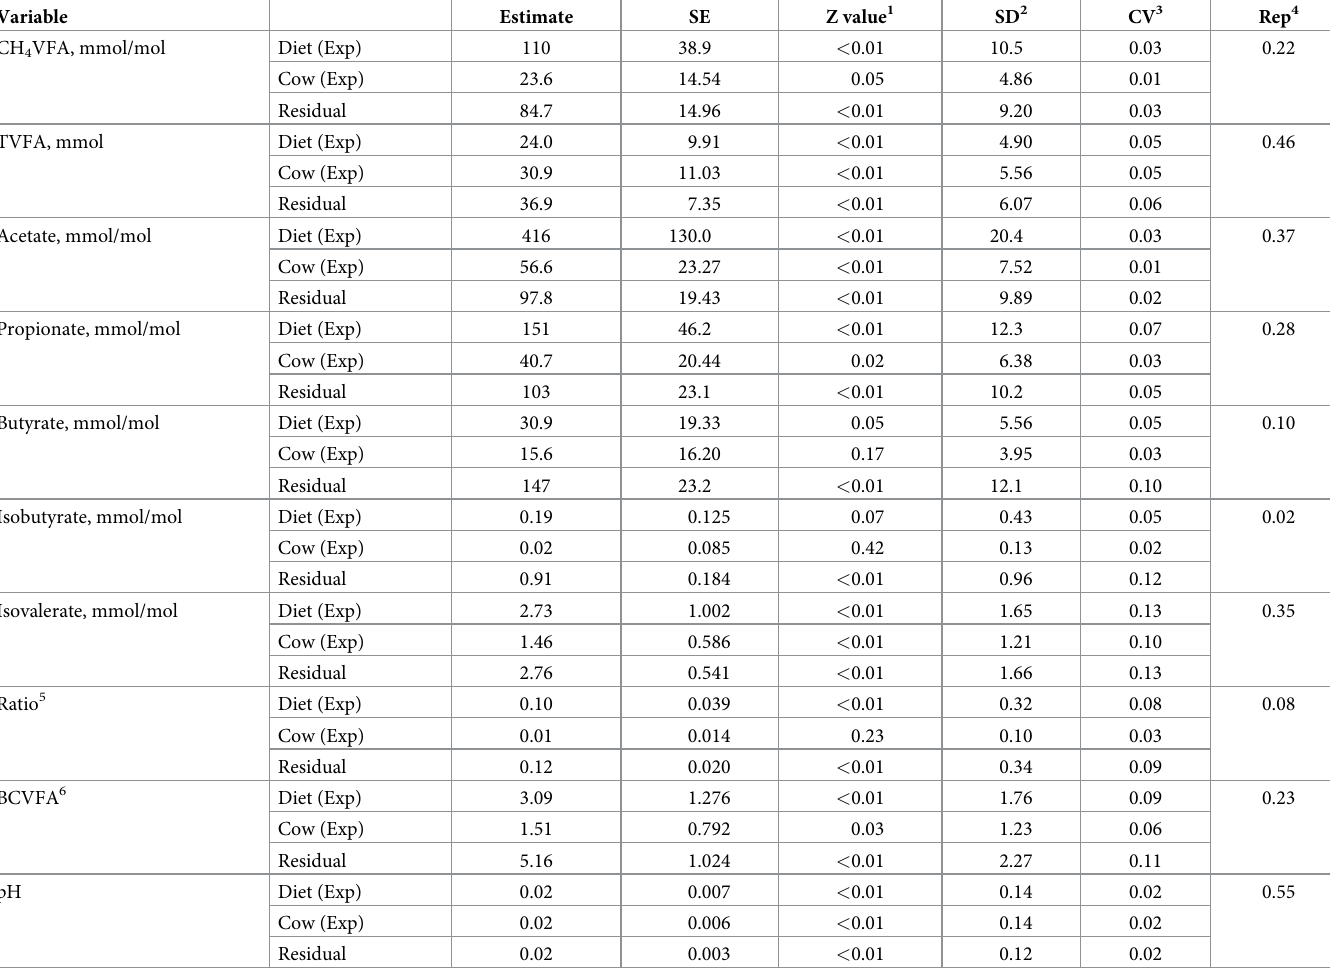
Table 4. Variance component estimates for methane estimate and rumen fermentation parameters in dairy cows.